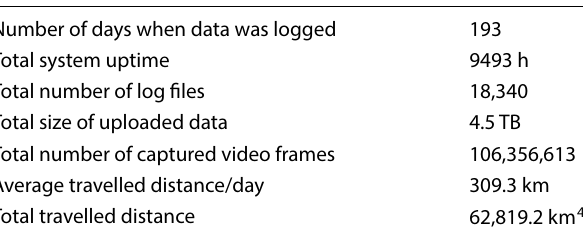
Table 2 Information about the log files Number of days when data was logged